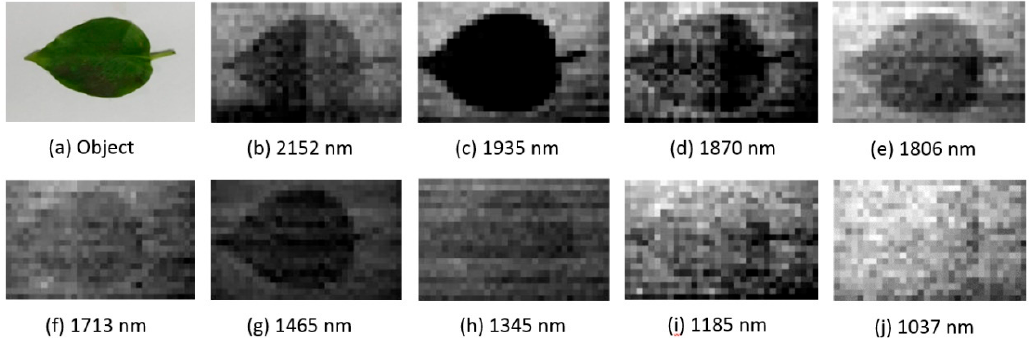
Figure 14. Images with different bands acquired by the SWIR AOTF imaging spectrometer based on SPI. In the 1465 nm and 1935 nm bands, the leaf exhibited less reflectance because H 2 O occupies an absorption peak in these